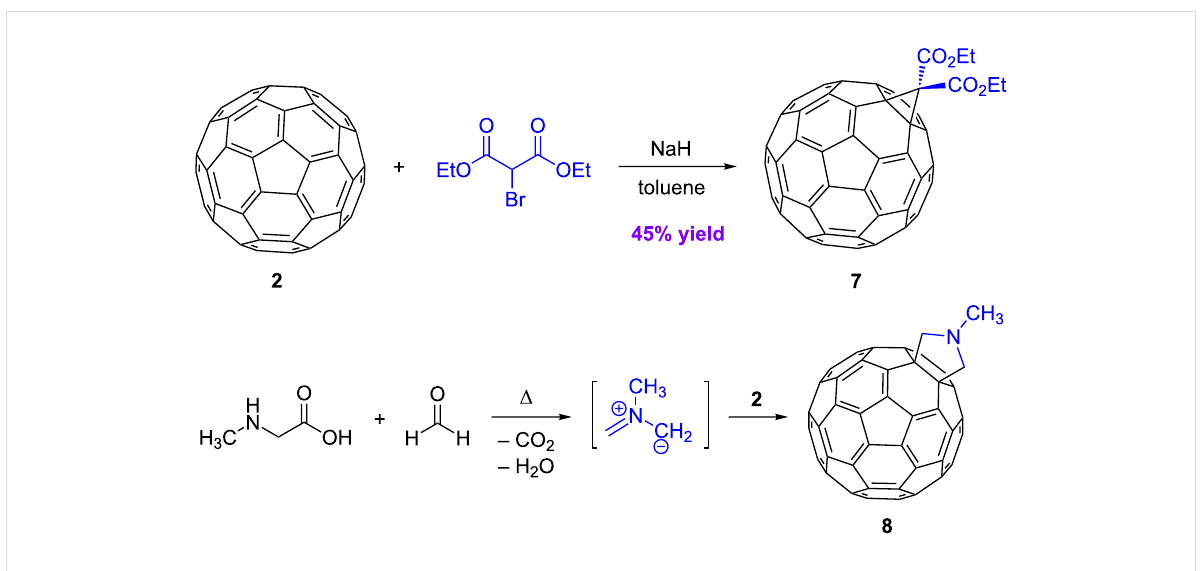
Scheme 1: Covalent functionalization of fullerene C 60 by the Bingel–Hirsch reaction and the Prato reaction.